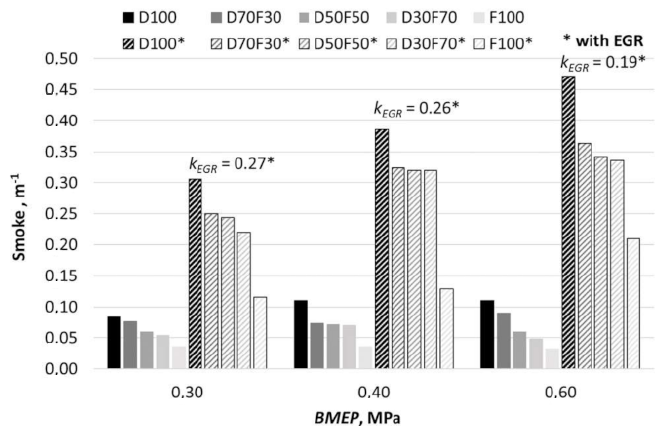
Figure 16. Dependence of the smoke on fuel composition and the engine